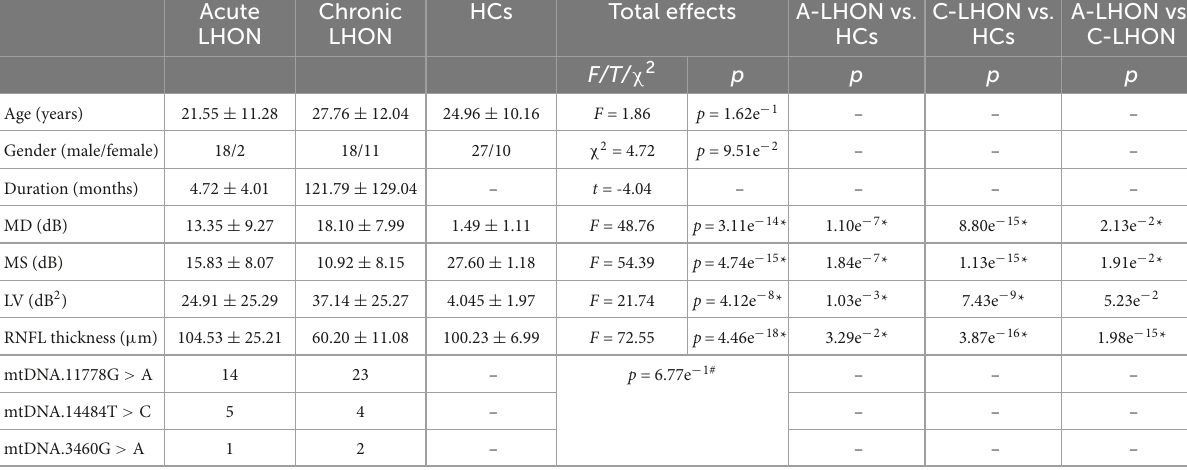
Data were reported as mean ± SD, and significant differences were labeled with asterisks (*). # Fisher exact test. LHON, Leber’s hereditary optic neuropathy; A-LHON, acute Leber’s hereditary optic neuropathy; C-LHON, chronic Leber’s hereditary optic neuropathy; HCs, healthy controls; MD, mean defect; MS, mean sensitivity; LV, loss of variance; RNFL, retinal nervefiberlayer.